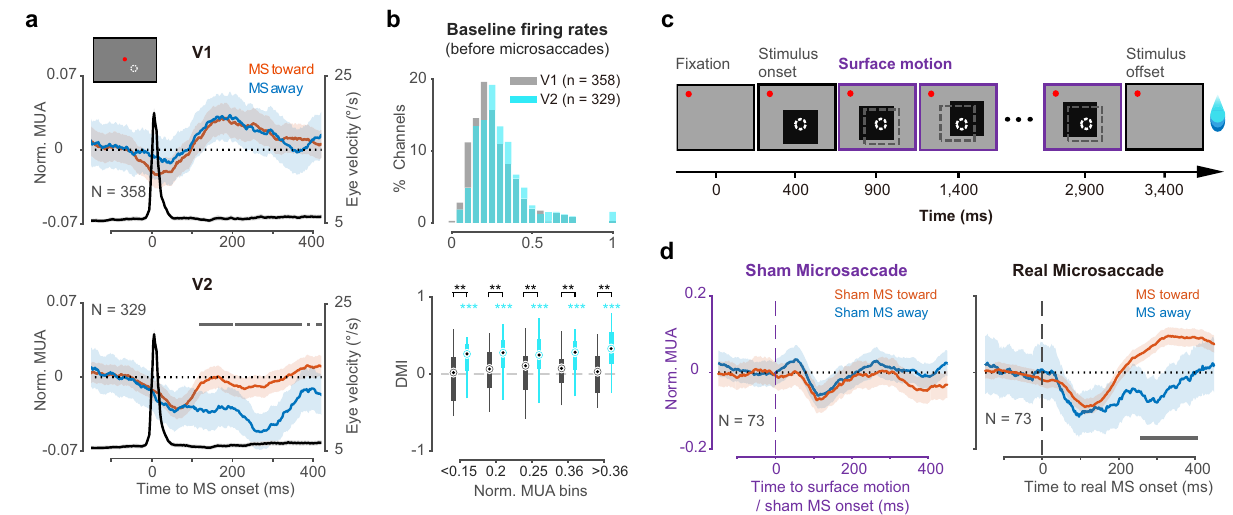
Fig. 2 | Direction-speci fi c microsaccade modulation in V2 is not stimulus- driven. a Normalized MUA around microsaccades in V1 and V2 in blank condi- tions. Black curves indicate the velocity of eye movement (mean±s.e., right vertical axis). b Distribution of normalized baseline fi ring rates for V1 ( n =358 sites) and V2 ( n =329 sites) before microsaccades. Box plots show the median (middle points), 25th, 75th percentile (box), and 5th and 95th percentile (whiskers) of the direction modulation index (DMI) among the V1 and V2 popu- lations at each baseline level (de fi ned by quintiles for baseline fi ring rates). Direction modulation in V2 was signi fi cantly stronger than those in V1 at all baseline levels (two-sided t test with FDR corrections, p = 4.35×10 − 5 , p =1.51×10 − 4 , p =6.2×10 − 4 , p =6.2× 10 − 4 , p =1.04×10 − 5 ). Asterisks denote